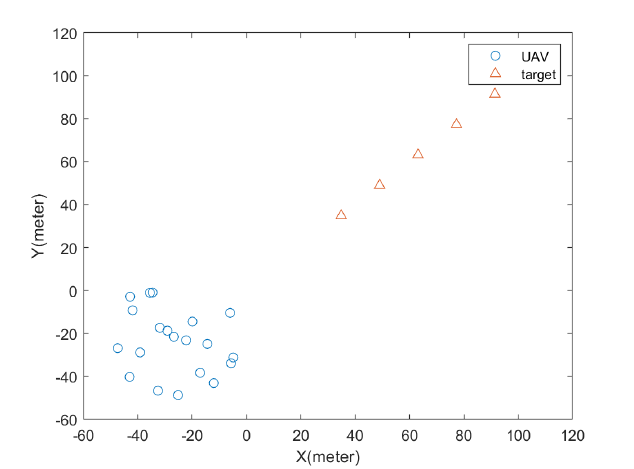
Figure 12. The simulation scenario of a single-unfixed